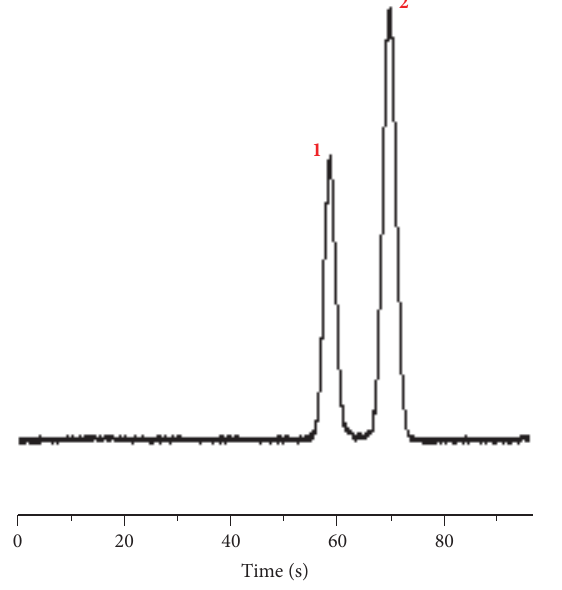
Figure 5: CZE separation of 10 𝜇 M FITC (peak 1) and 10 𝜇 M fluorescein (peak 2) using the AICEI